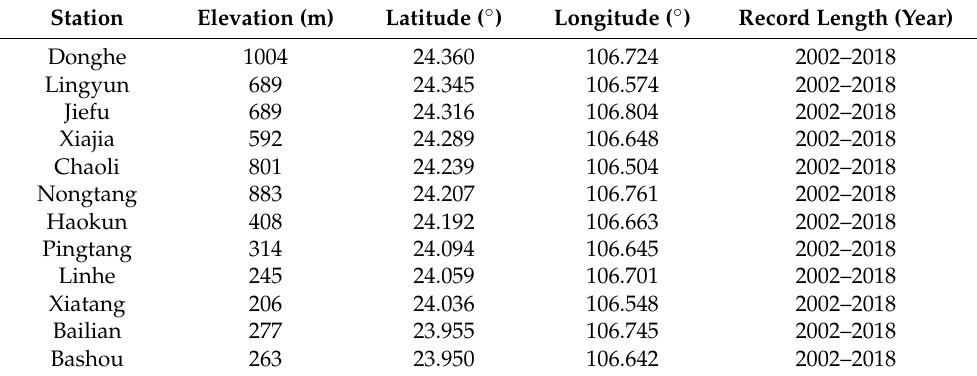
Table 1. Detailed information of stations in the Chengbi River